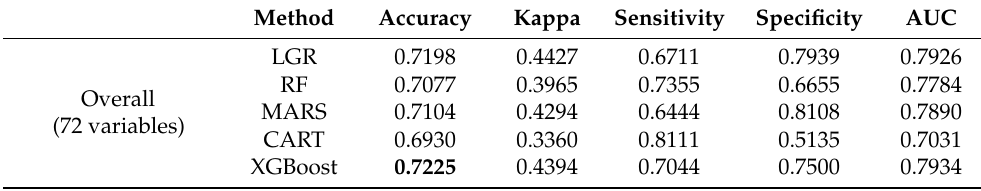
Table 3. Performance evaluation of prediction models on nonselection and after feature